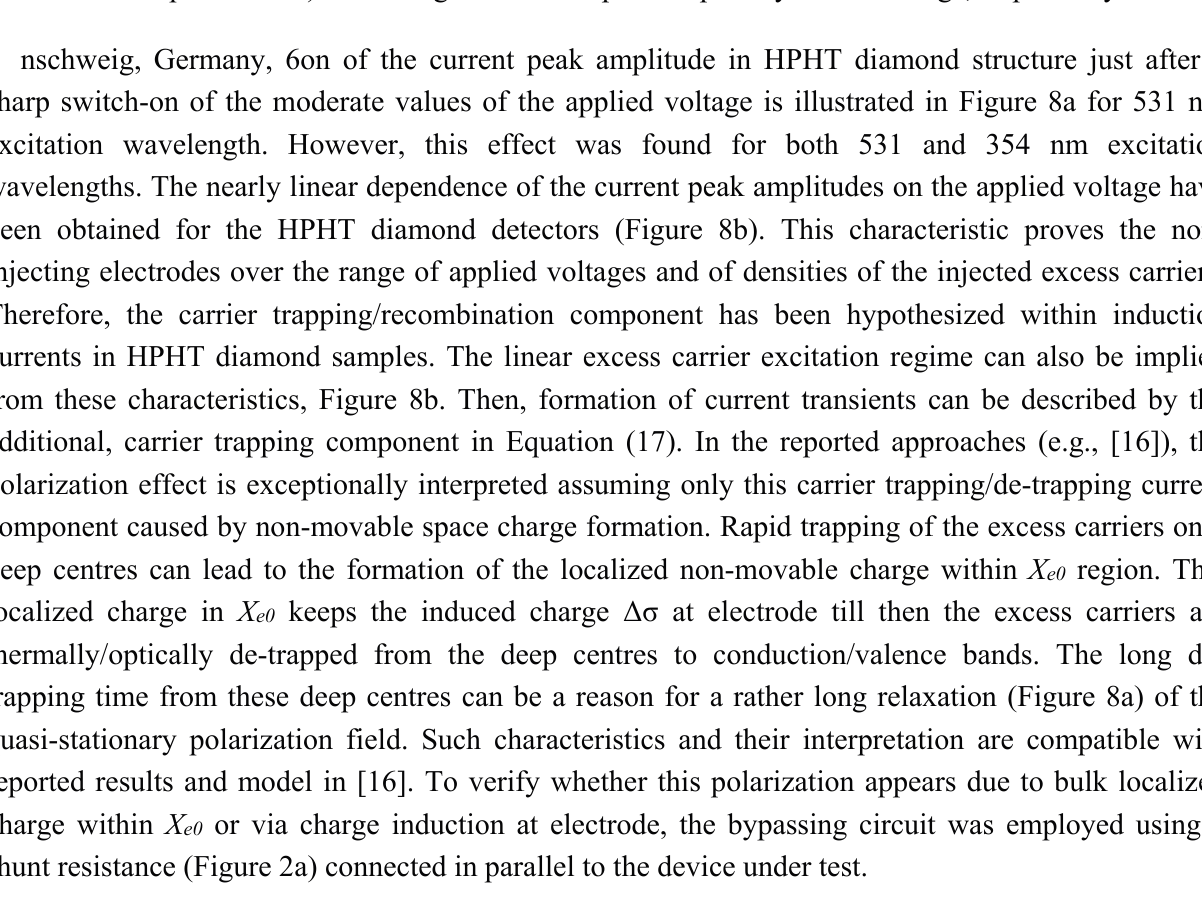
Figure 9. ( a ) A sequence of the charging current amplitudes (right scale) for a 700 ms pulse of the unipolar bias (16 V) voltage (left scale) applied to CVD diamond. The solid (red) curve is an eye-guide which shows the charging current decrease after each laser pulse of duration 0.4 ns in sequence of 70 laser pulses; ( b ) A sequence of the charging current amplitudes (right scale) for the 70 ms voltage pulses of the bipolar ± 14 V bias voltage (left scale) applied on CVD diamond capacitor. The solid (red) curve is again an eye-guide which shows the charging current (as vertical lines in this display scale) reduction after each laser pulse of duration 0.4 ns in sequence of 7 laser pulses (with 100 Hz repetition rate) for the negative and the positive polarity of bias voltage,